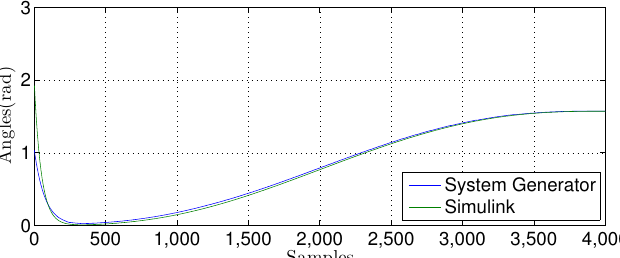
Figure 32. Comparisonof the simulation results in Matlab Simulink and system generator for the MLP-BP using W = 14.